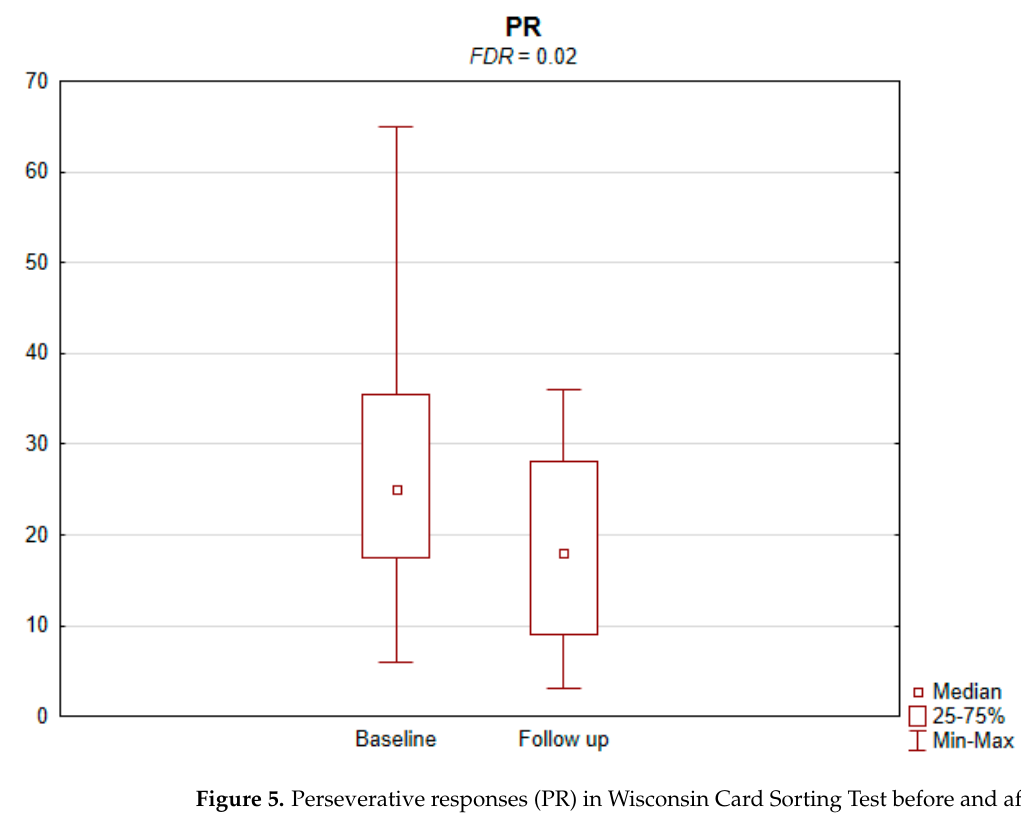
Figure 5. Perseverative responses (PR) in Wisconsin Card Sorting Test before and after the intervention. FDR —false discovery rate.